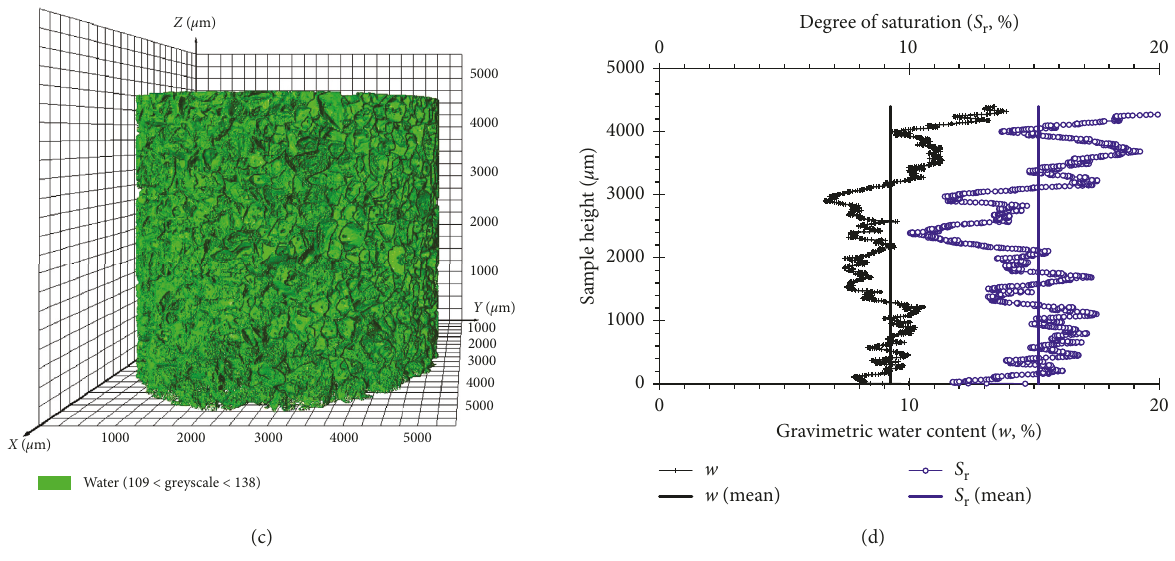
Figure 7: 3D reconstruction and water distribution within the compacted Zhuhai sand. (a) 3D reconstruction. (b) Enlarged view. (c) Segmented water phase. (d) Profile of water content and degree of saturation.